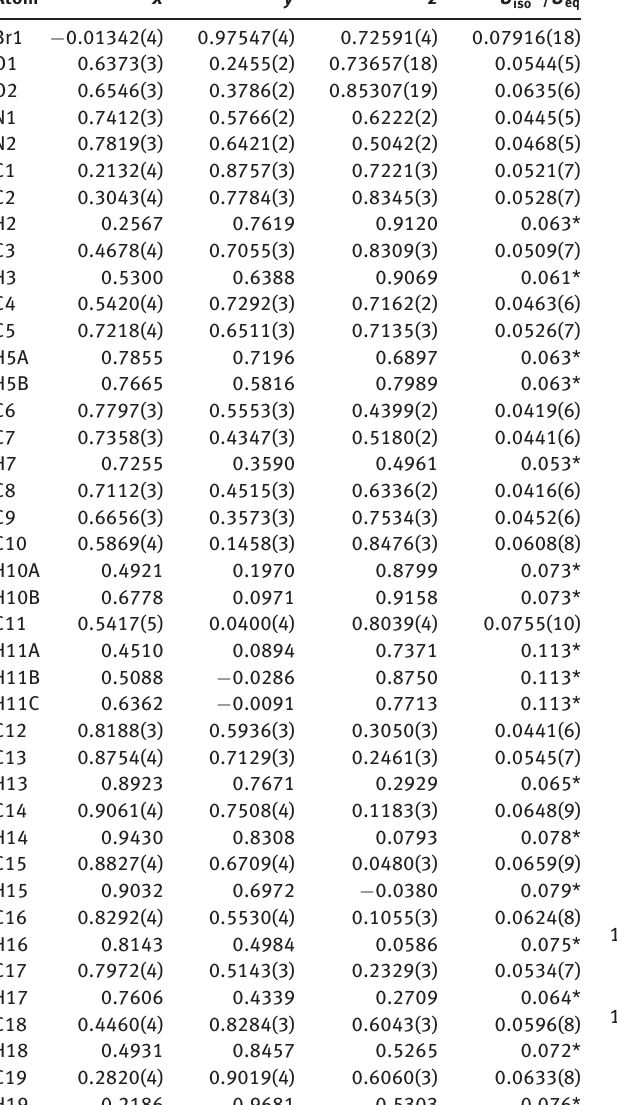
Table 2: Fractional atomic coordinates and isotropic or equivalent isotropic displacement parameters (Å 2